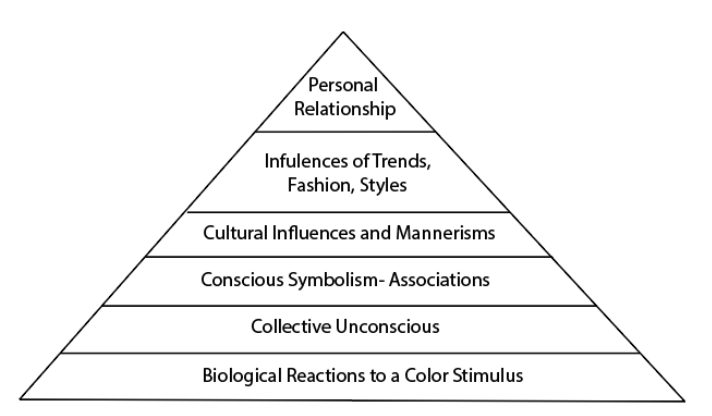
Figure 2. Color Experience Pyramid